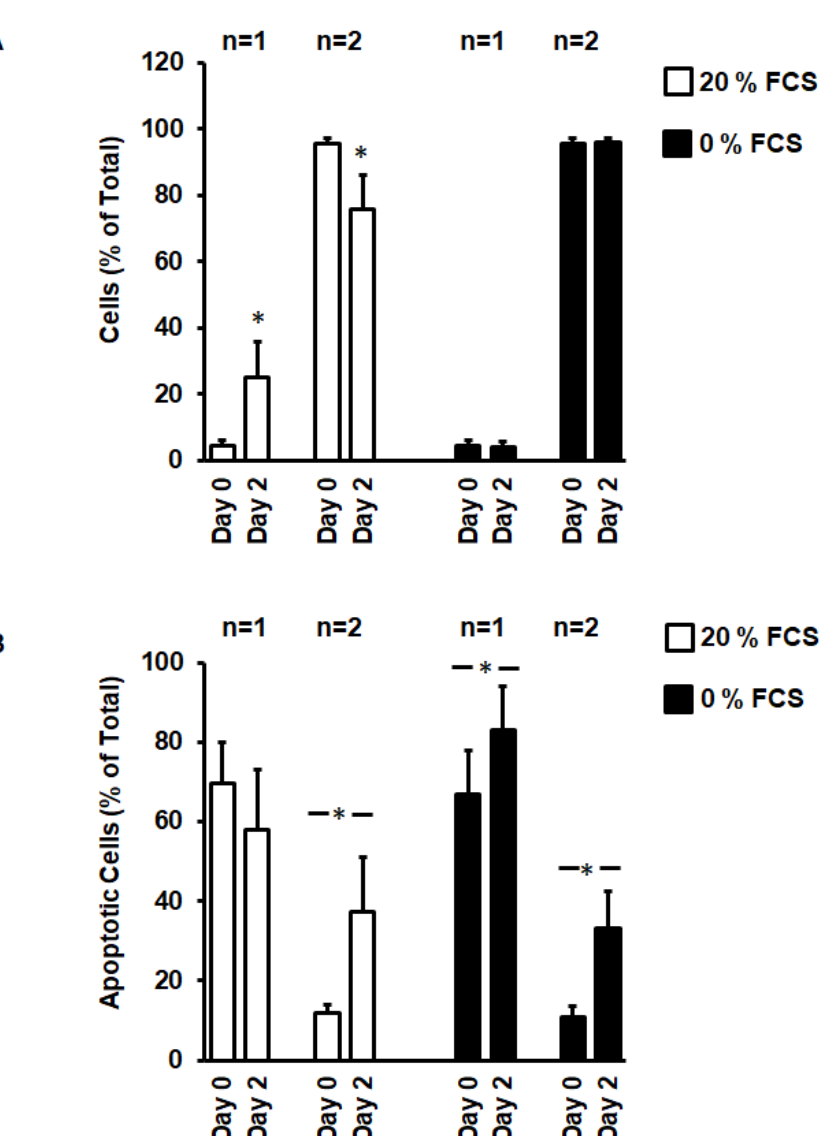
Figure 4. Ratio between mono ( n = 1) and binucleated ( n = 2) cells at day 0 and 2 in the presence and absence of fetal calf serum ( A ). Number of cells undergoing apoptosis (identified by DNA condensation—see Figure 1) under these conditions ( B ). Data are means ± SD from n = 8 preparations (237–410 cells per preparation). (*, p < 0.05 vs. Day